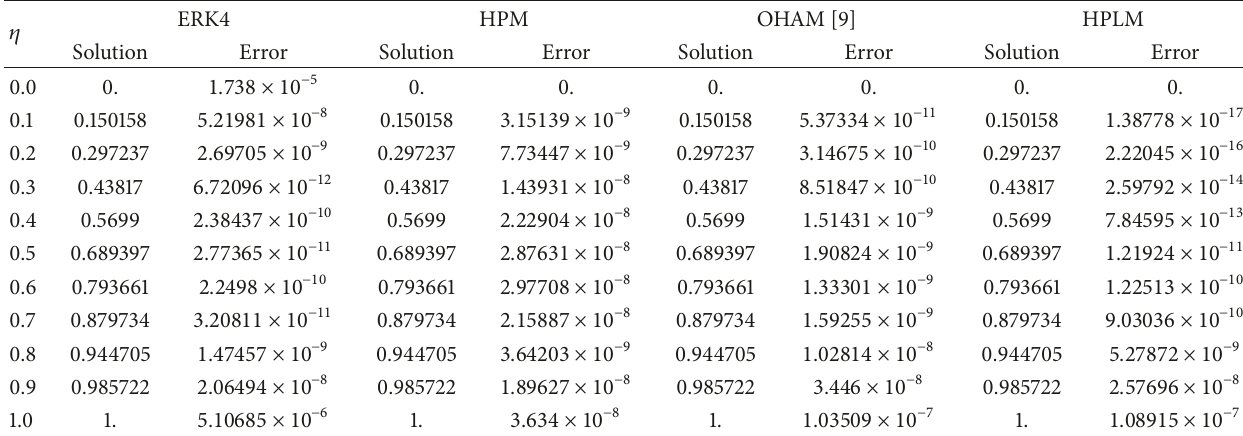
Table 1: Comparison of solutions along with absolute residual errors for various analytical and numerical schemes at 𝑅 = 0.1 .